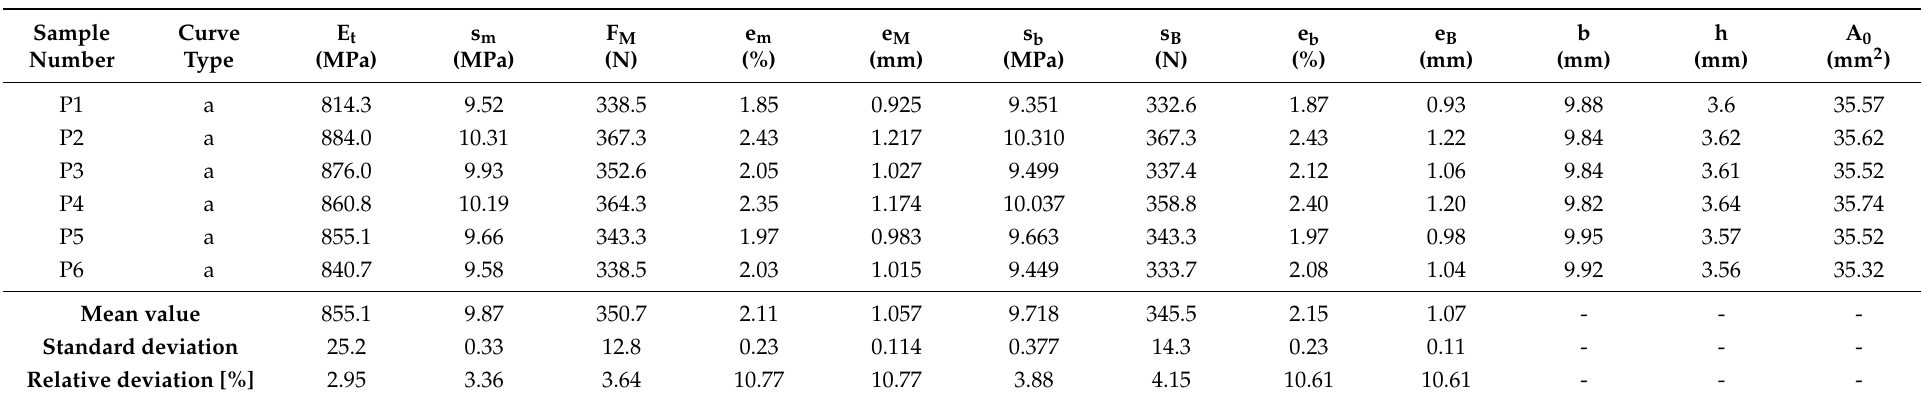
Table A41. Results of the tensile tests of